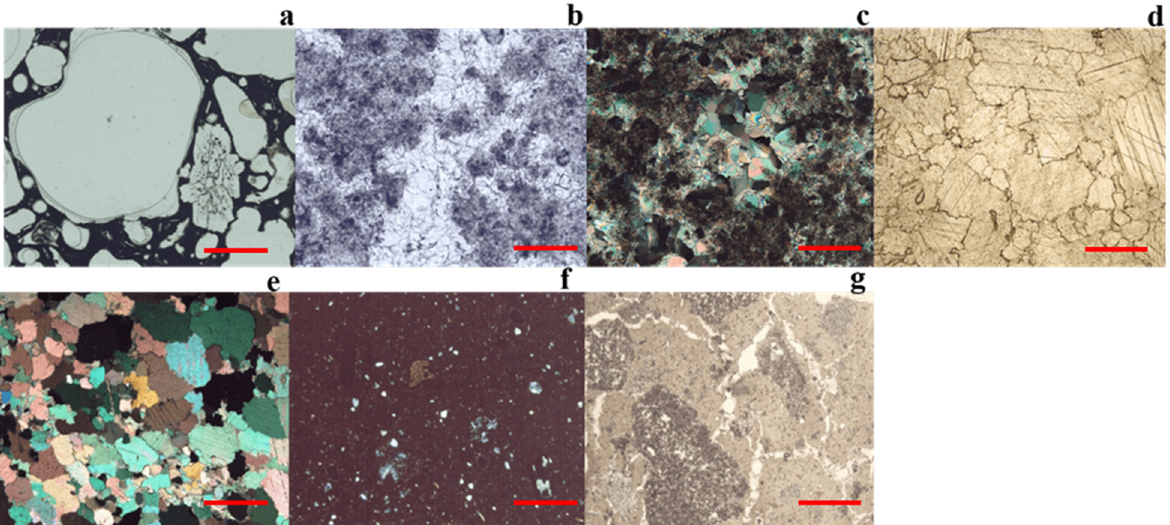
Figure 15. Microphotographs of: ( a ) sample P1, pumice; ( b ) sample T1, travertine; ( c ) sample L2, limestone; ( d ) sample MA1, marble; ( e ) sample C1, ceramic; ( f ) sample PL1, plaster; ( g ) Micas represented accessory minerals. All the microphotographs are at plane polarized light, except than c and d2 that are at crossed polarized light. All the samples are investigated at 4× magnifications. Line red bars = 1 mm.